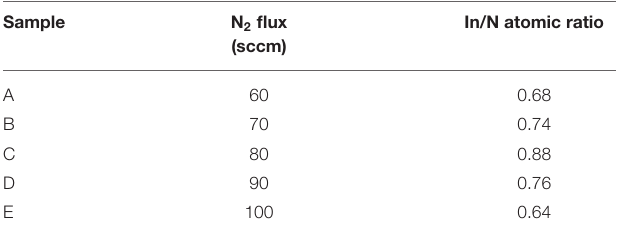
TABLE 2 | The content of InN films deposited at different N 2